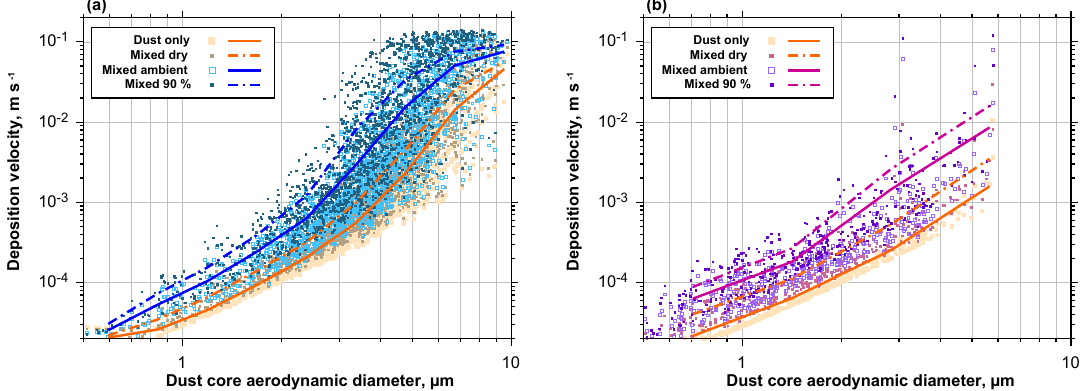
Figure 17. Deposition velocities calculated with the Piskunov model for internal admixture of sea salt (a) or sulfate (b) for the mixed particles observed at Ragged Point. Velocities are given for the unmixed dust core and internal mixtures at dry conditions, at ambient relative humidity and at 90% relative humidity. The lines show the according means. Note that variation in deposition velocity for the same dust core size arises from variation in wind speed and admixed fraction.